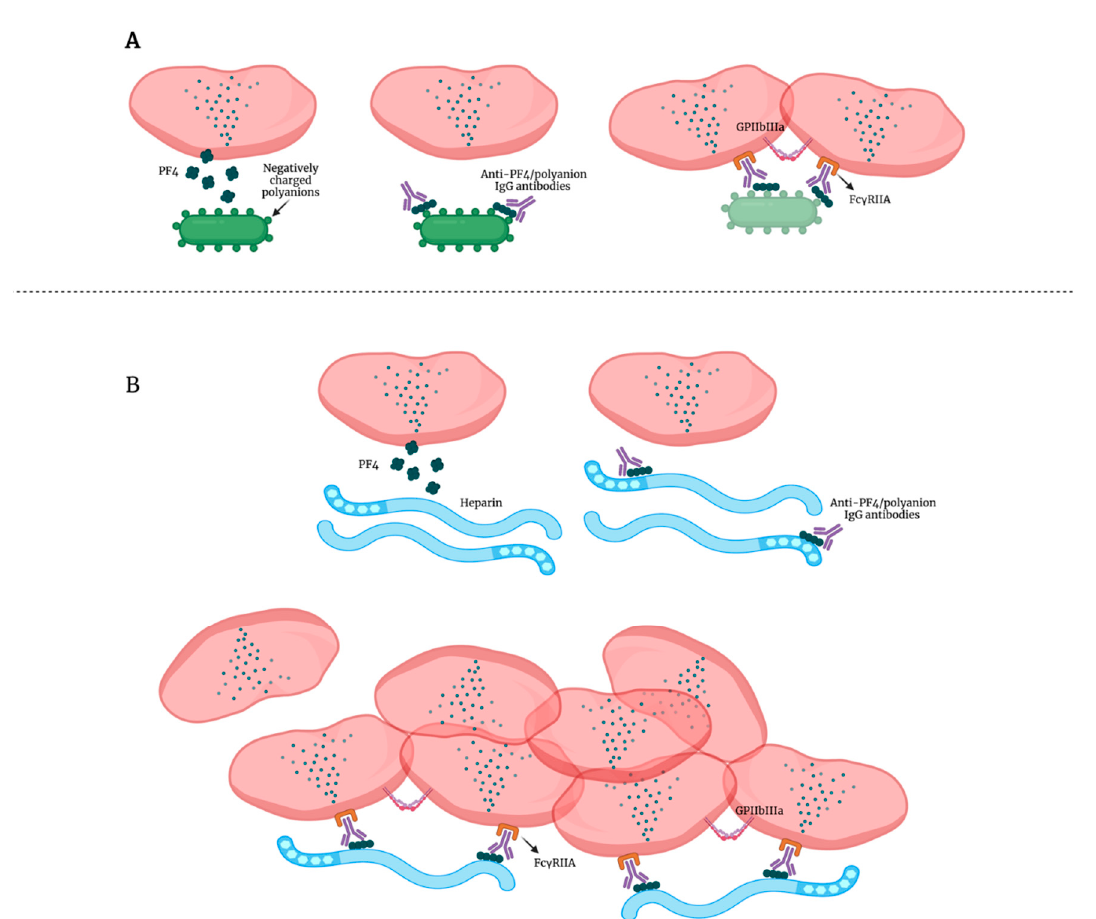
Figure 2. ( A ) PF4 role in bacterial killing. PF4 (platelet factor 4) stored in alpha-granules is released. When PF4 binds negatively charged polyanions, it undergoes a conformational change. This binding leads production of anti-PF4/polyanion IgG antibodies. The IgG–PF4 complex binds the Fc γ RIIA receptor on the platelet surface and promotes bacterial killing. ( B ) PF4 role in HIT. PF4 binds negatively charged molecules like heparin leading to the formation of anti-PF4/polyanion IgG antibodies. The IgG–PF4 complexes induce HIT (heparin-induced thrombocytopenia), an immune complication of heparin therapy clinically associated with thrombocytopenia and thromboembolic complications.